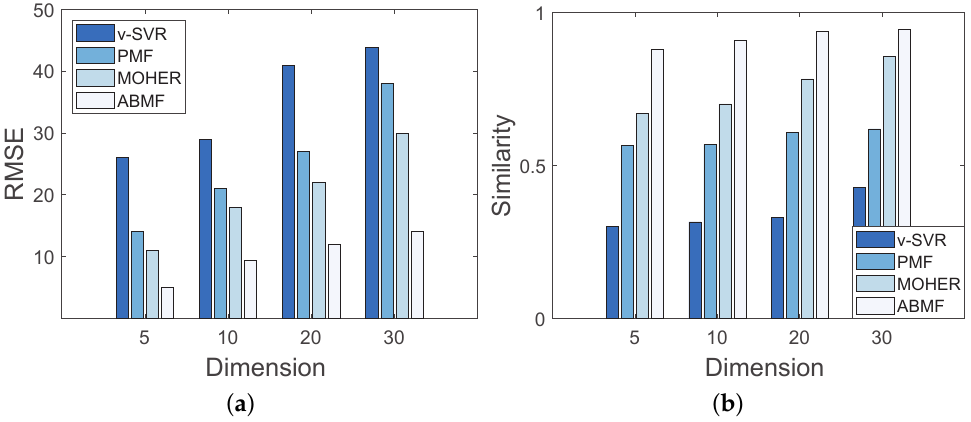
Figure 10. Performance with different dimensions on simulation dataset: ( a ) Performance on RMSE; ( b ) Performance on